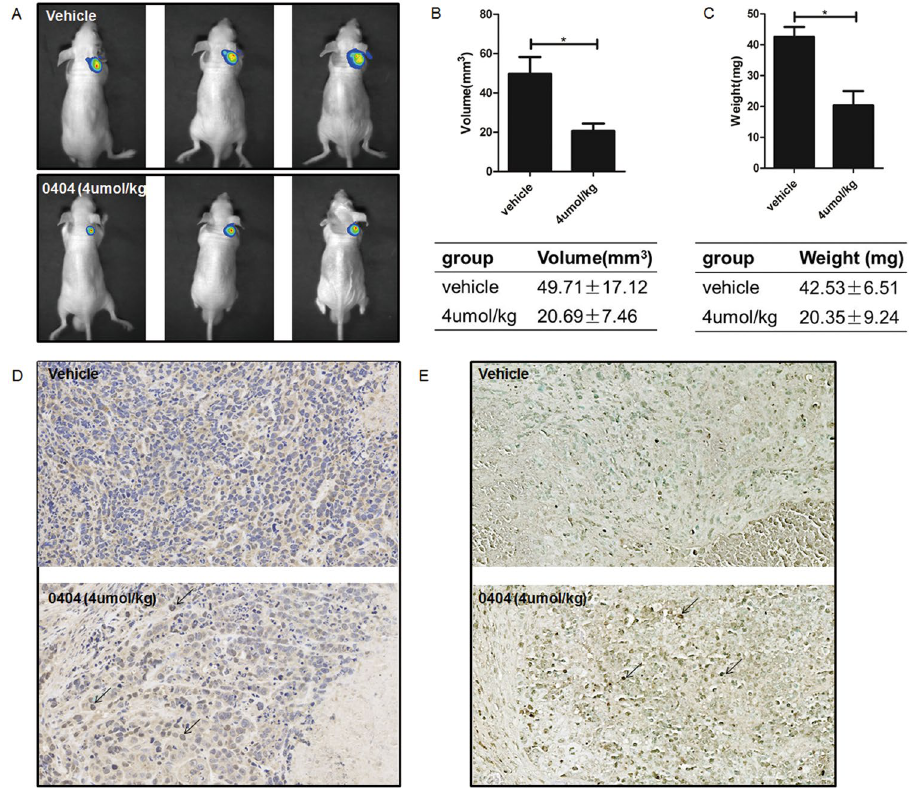
Figure 3. 0404 inhibited hepatocellular tumor growth in vivo . ( A ) Luciferase emission showed that 0404 inhibited the tumor growth in vivo . ( B and C ) 0404 significantly inhibited the tumor volume and weight excised from nude mice at day 25. ( D ) p53 levels were up-regulated in the HepG2 tumors excised from nude mice after treatment with 0404. ( E ) TUNEL assay was used to detect the cell apoptosis in the HepG2 tumors excised from nude mice after treatment with